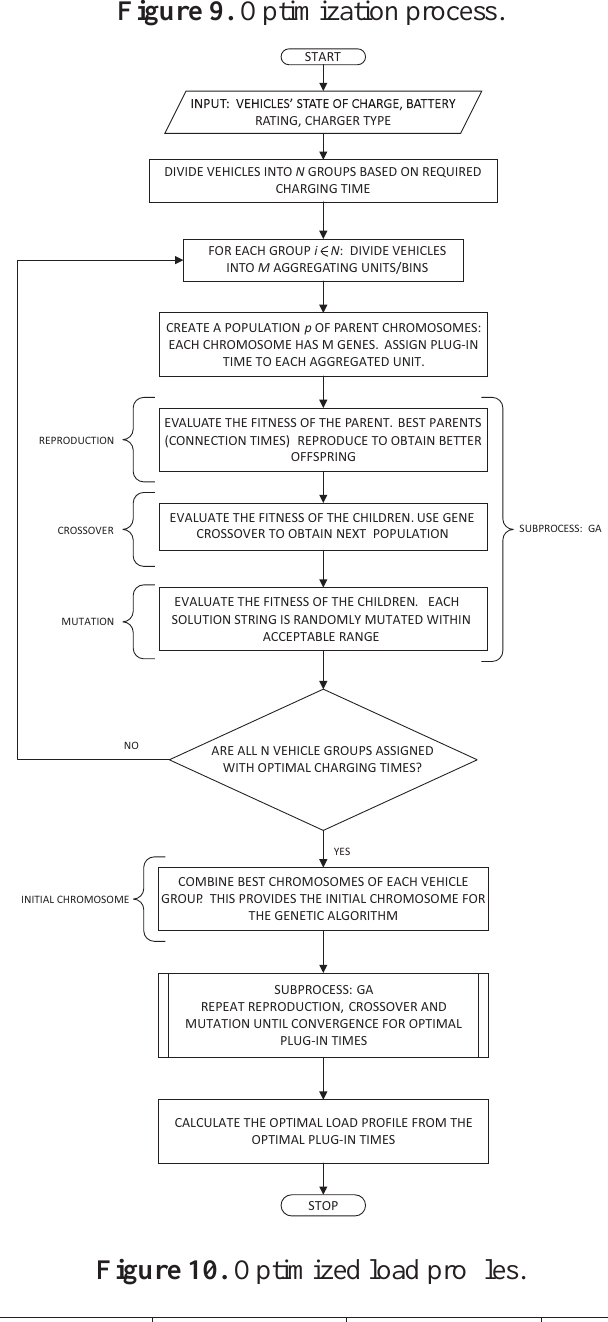
Figure 9. Optimization process.